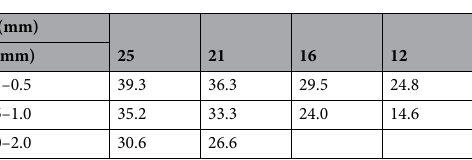
D p (mm) 12 10 N 25 40 78 Total cross sectional area of pipes (mm 2 ) 2826.0 Table 2. Equivalent diameter D p and number N of parallel pipes for a porous bed with D = 25 mm.